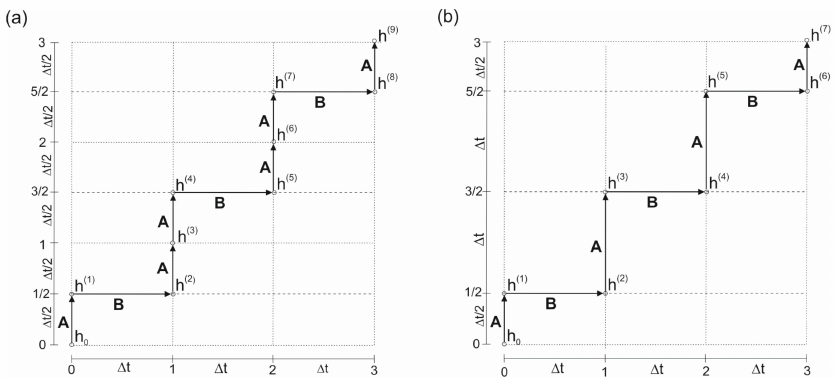
Figure 2. Schematic sketch of the Strang method (for 3 ∆ t): ( a ) standard Strang splitting (Equations (14)–(16)), ( b ) modified Strang splitting (Equations